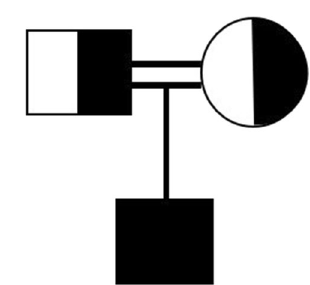
Fig. 1 Family pedigree of Index